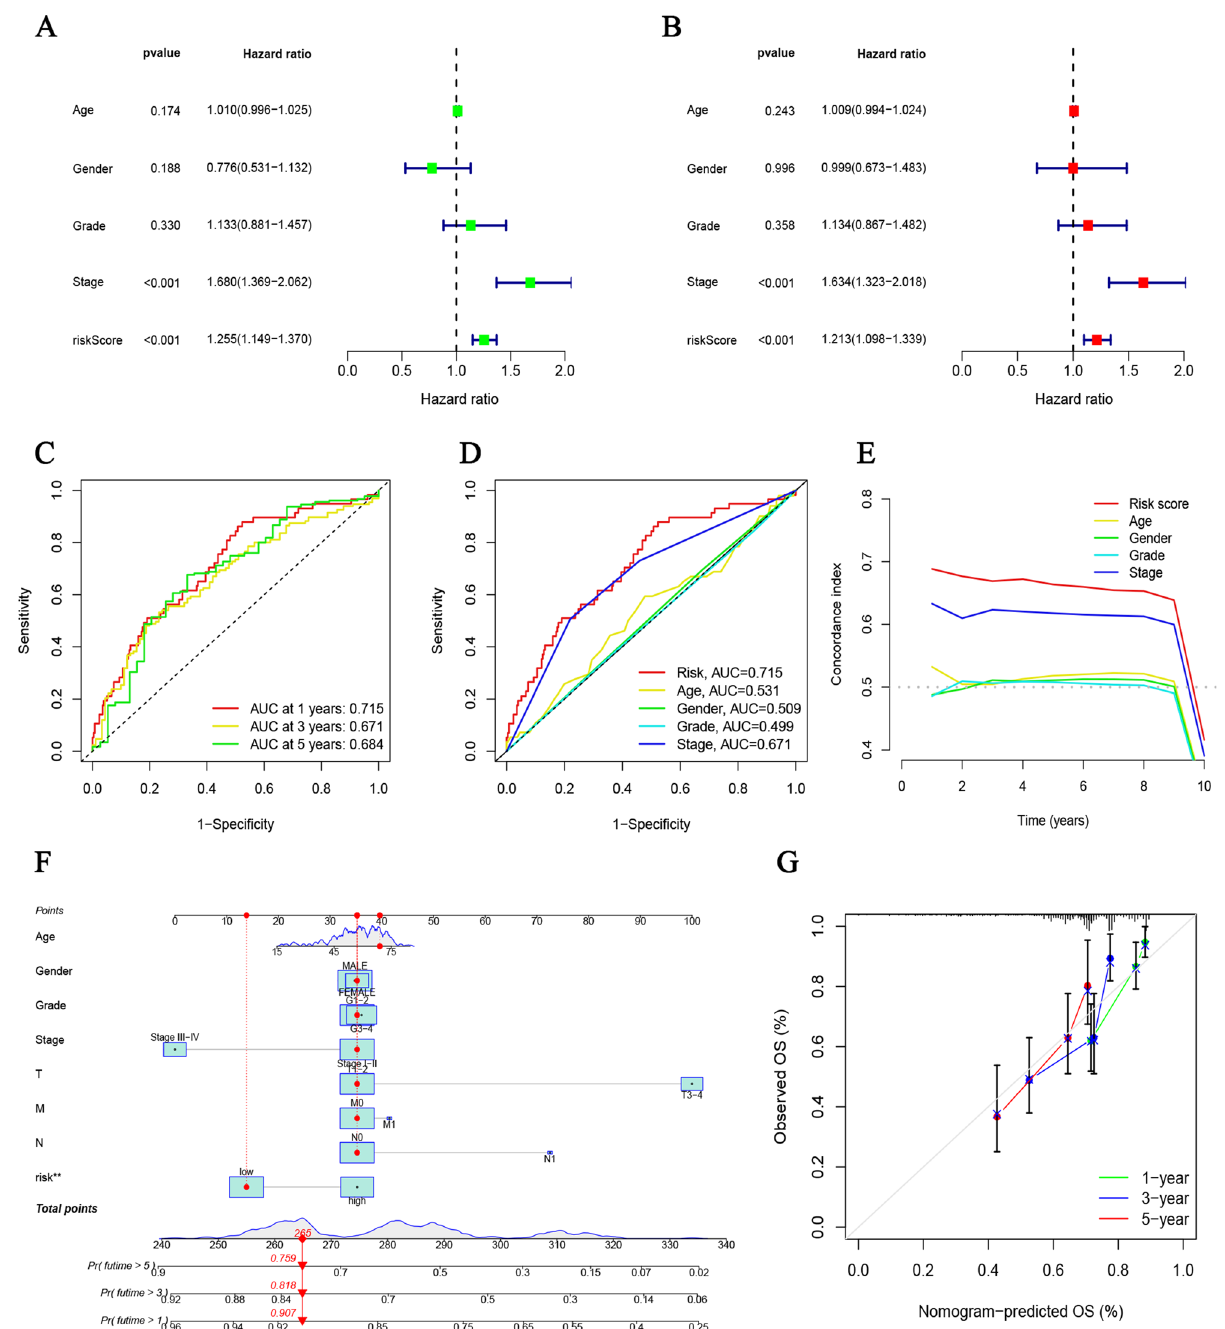
Figure 4. Internal validation of prognosis risk model and Nomogram demonstration. ( A , B ) Cox regression analyses of clinicopathologic features and risk scores. ( C ) The ROC curves for 1-, 3- and 5-years OS. ( D , E ) The ROC curves and C-index of risk score and clinicopathologic features. ( F , G ) Nomogram and calibration curves of the prognosis